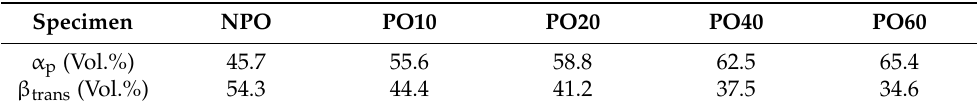
Table 4. The volume fraction of α p and β trans phases within 50 µ m of the surface layer for different